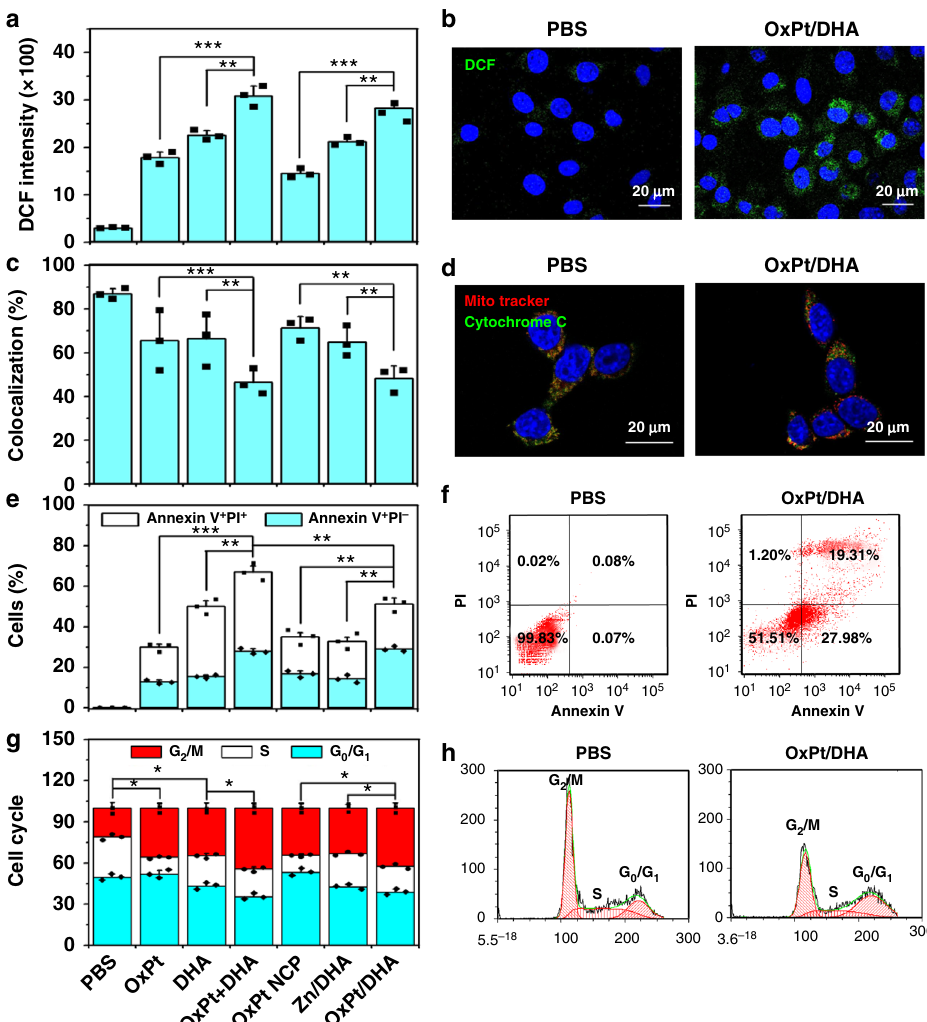
Fig. 4 Programmed cell death in colorectal cancer cells by ROS generation. a , b ROS generation in cells treated with OxPt/DHA, as indicated by the green fl uorescence of 2 ′ ,7 ′ -dichloro fl uorescein (DCF) that was oxidized from 2 ′ ,7 ′ -dichlorodihydro fl uorescein diacetate (H 2 DCFDA) by ROS. c , d Release of cytochrome c from mitochondria in cells incubated with OxPt/DHA. Mitochondria (red fl uorescence) and cytochrome c (green fl uorescence) were stained by MitoTracker Red CMXRos and anti-cytochrome c antibody, respectively. e , f Apoptosis induced by OxPt/DHA. After treatment, cells were stained by Alexa Fluor 488-labelled Annexin V and propidium iodide (PI) and analysed by fl ow cytometry. g , h Cell cycle arrest caused by OxPt/DHA. Treated cells were fi xed with 70% ethanol overnight, treated with RNase A, stained by PI, and analysed by fl ow cytometry. Data are expressed as means ± SD, and one of three repetitions with similar results is shown here. * p < 0.05, ** p < 0.01, *** p < 0.001 by Student ’ s two-tailed t test. OxPt oxaliplatin, DHA dihydroartemisinin, ROS reactive oxygen